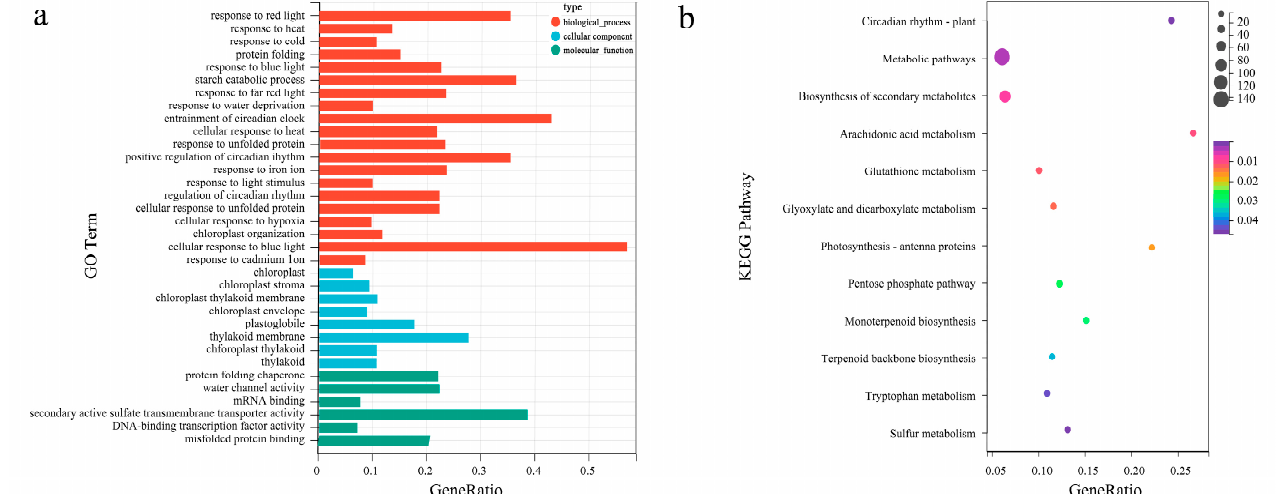
Figure 3. Gene Ontology (GO) functional annotation and Kyoto Encyclopedia of Genes and Genomes (KEGG) enrichment analysis of DEGs. ( a ) GO enrichment classification of differentially expressed genes. The top 10 terms with the largest number of differential genes were taken for the plot, the horizontal coordinate is the number of differential genes in that GO term, and the vertical coordinate is the specific GO term. ( b ) KEGG enrichment classification of DEGs. The horizontal coordinate is the − log10 p -value of the DEGs in the KEGG pathway name, and the vertical coordinate is the specific pathway name. The darker the orange–red color, the smaller the − log10 p -value; the darker the blue–green color, the larger the − log 10 p -value.